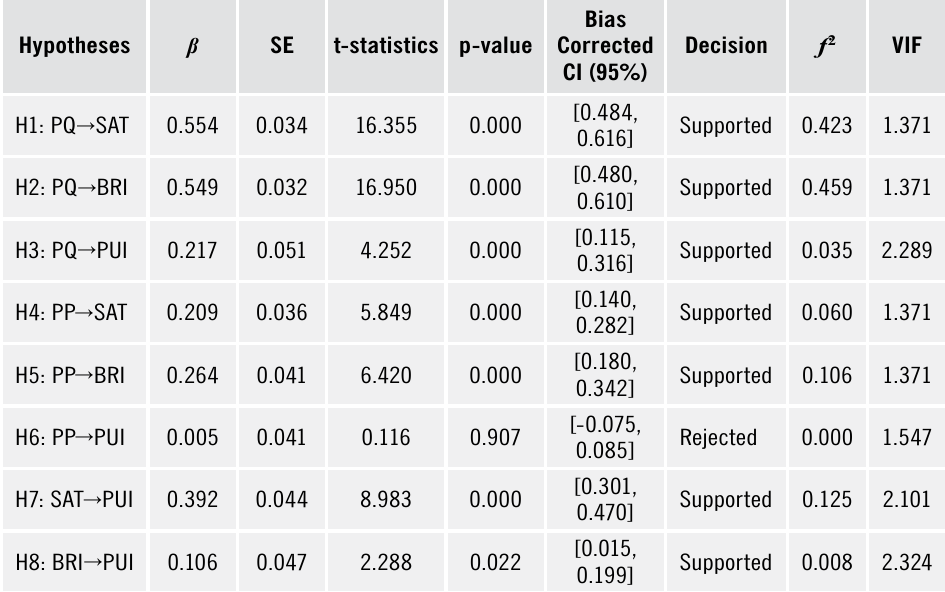
Table 6. Results of hypotheses testing